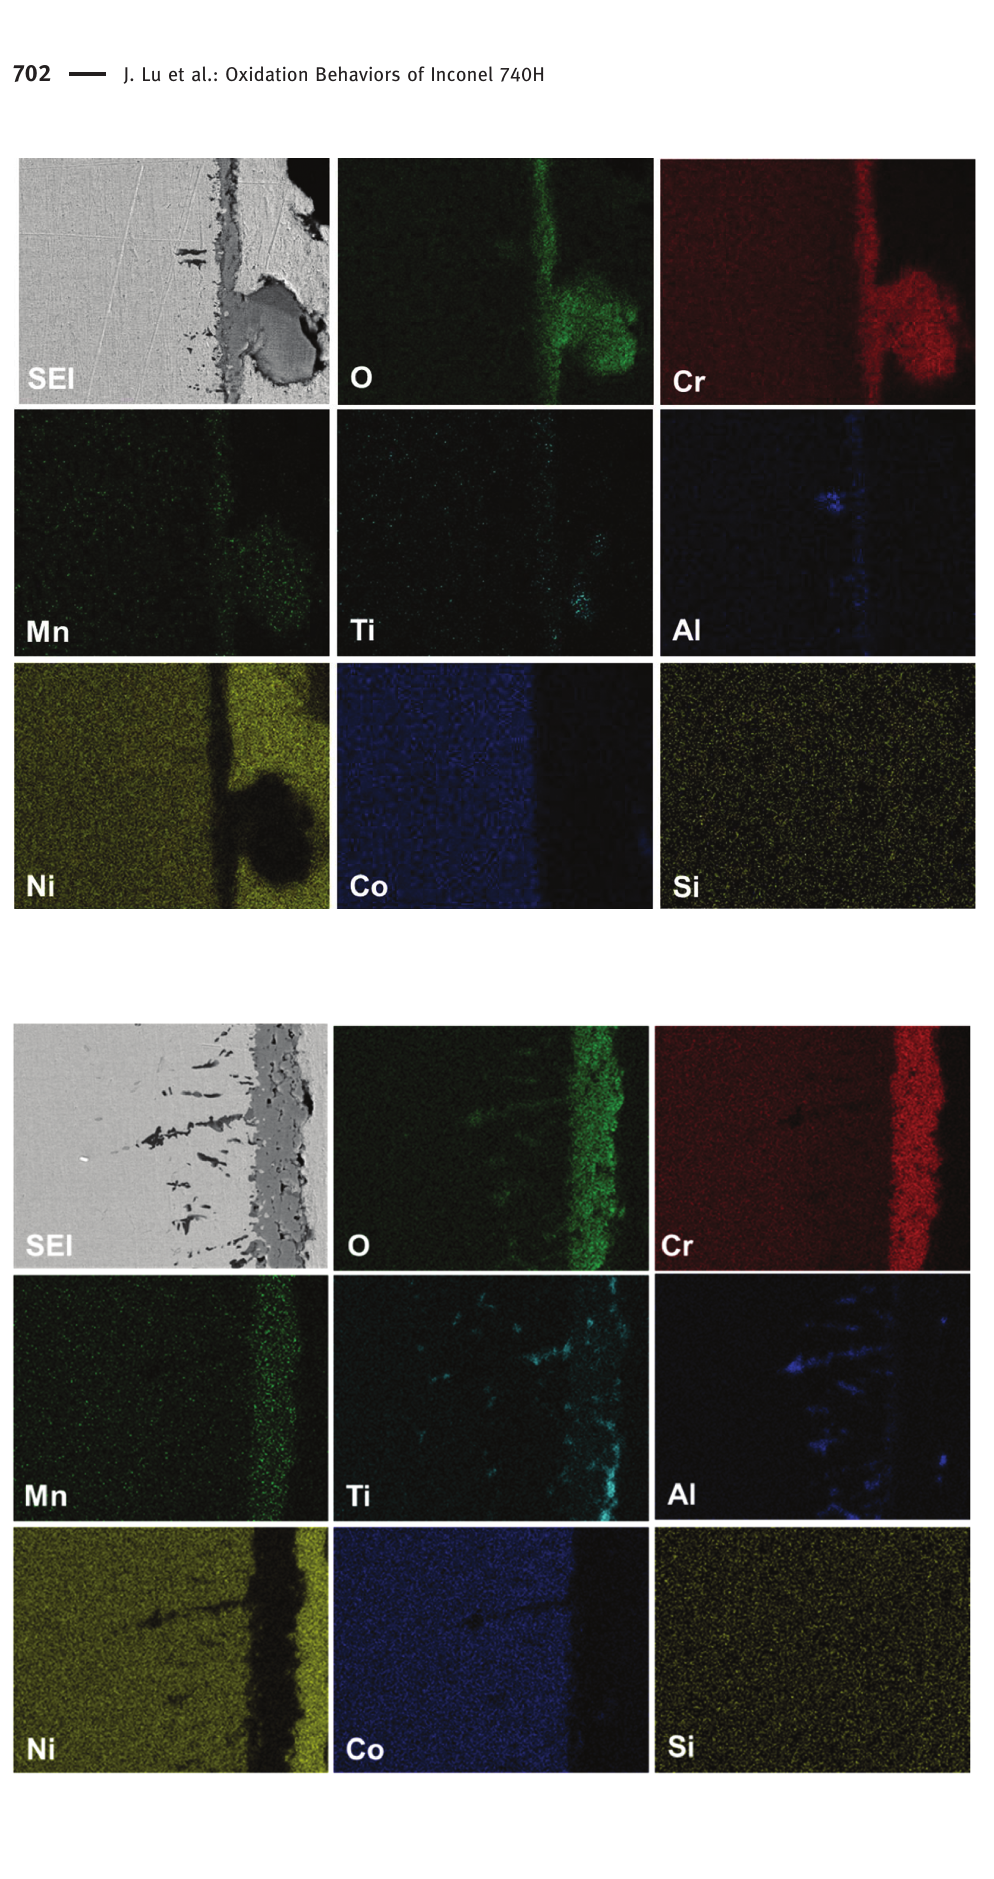
Figure 6: Element mapping of Inconel 740H after oxidation in static air at 850°C for 1,000 h.